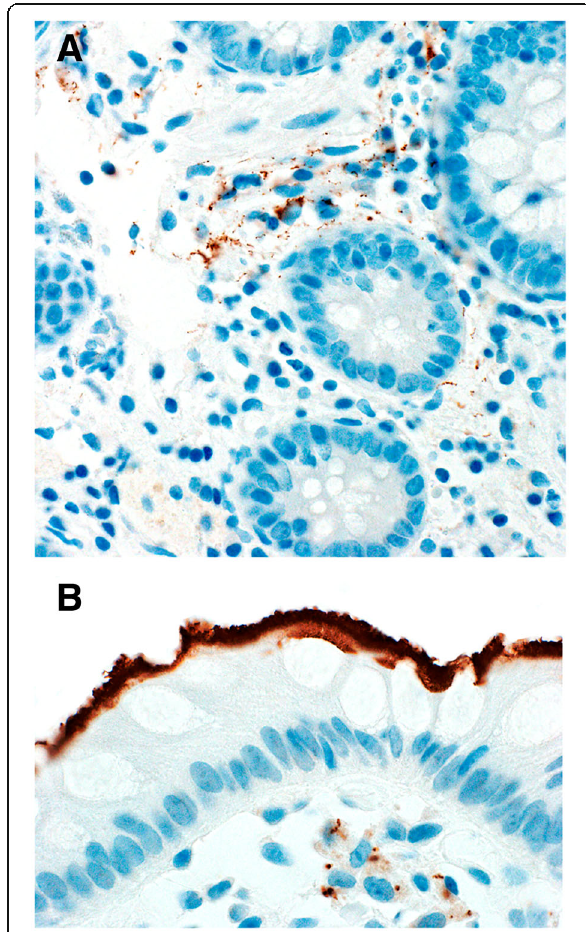
Fig. 2 a The T. pallidum immunostain highlights numerous spiral organisms in the lamina propria. Some macrophages also contain ingested organisms. These findings are unapparent on H&E or Warthin Starry stains (Original magnification ×600). b This T. pallidum immunostain shows not only the colonization of the surface epithelium characteristic of intestinal spirochetosis, but also reveals lamina propria macrophages harboring spiral organisms (Original magnification